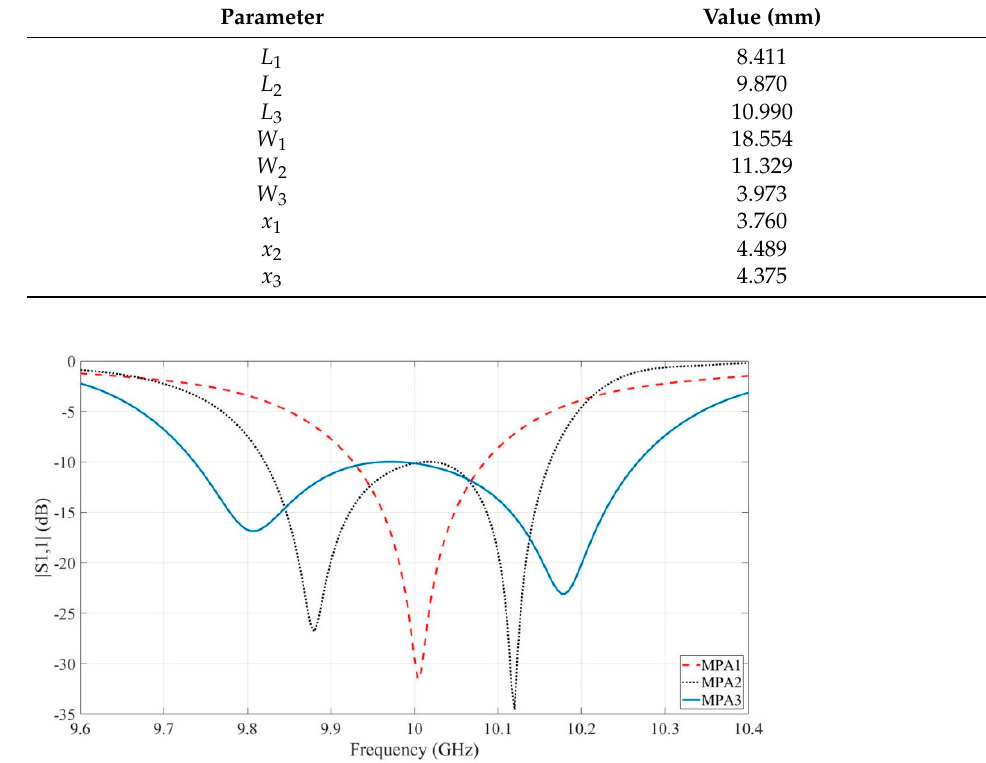
Figure 8. Simulated reflection coefficient for MPA1, MPA2, and MPA3.